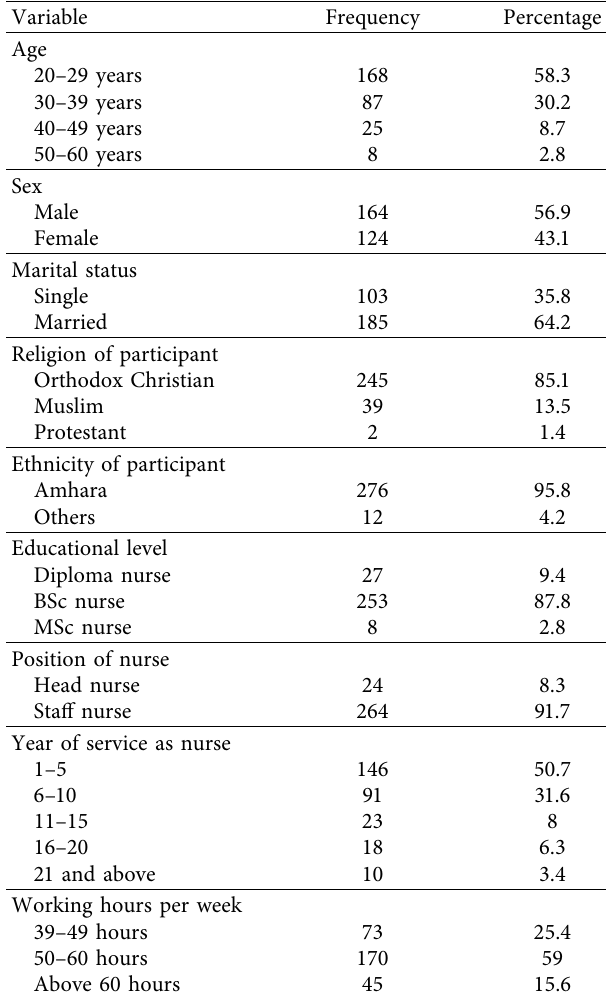
Table 1: Sociodemographic characteristics of nurses working in Amhara regional state referral hospitals, 2019 ( n �